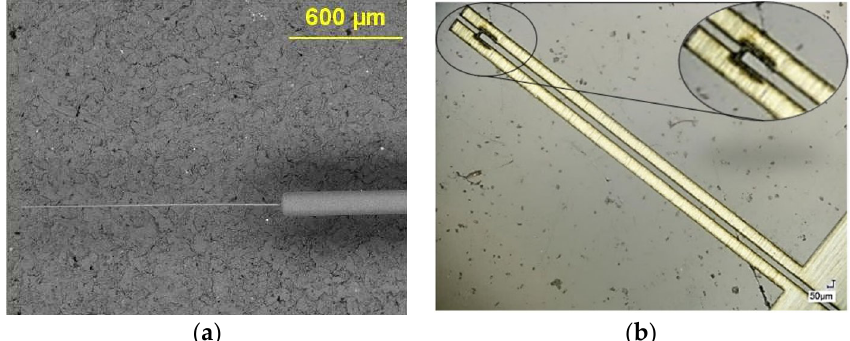
Figure 1. Original proposed design of the scanner: ( a ) SEM image of the cantilever fiber; ( b ) Laser cut-out of the actuator brass foil.